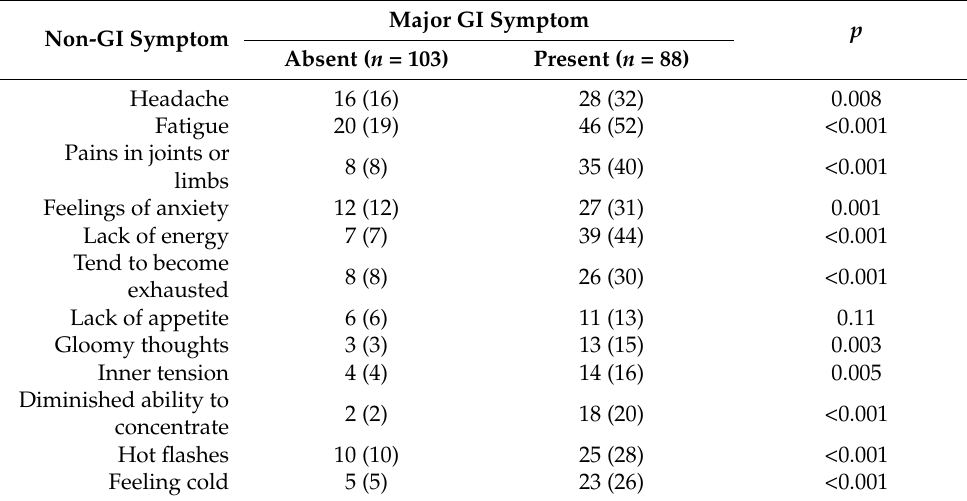
Table 1. Association of non-GI symptoms with major GI